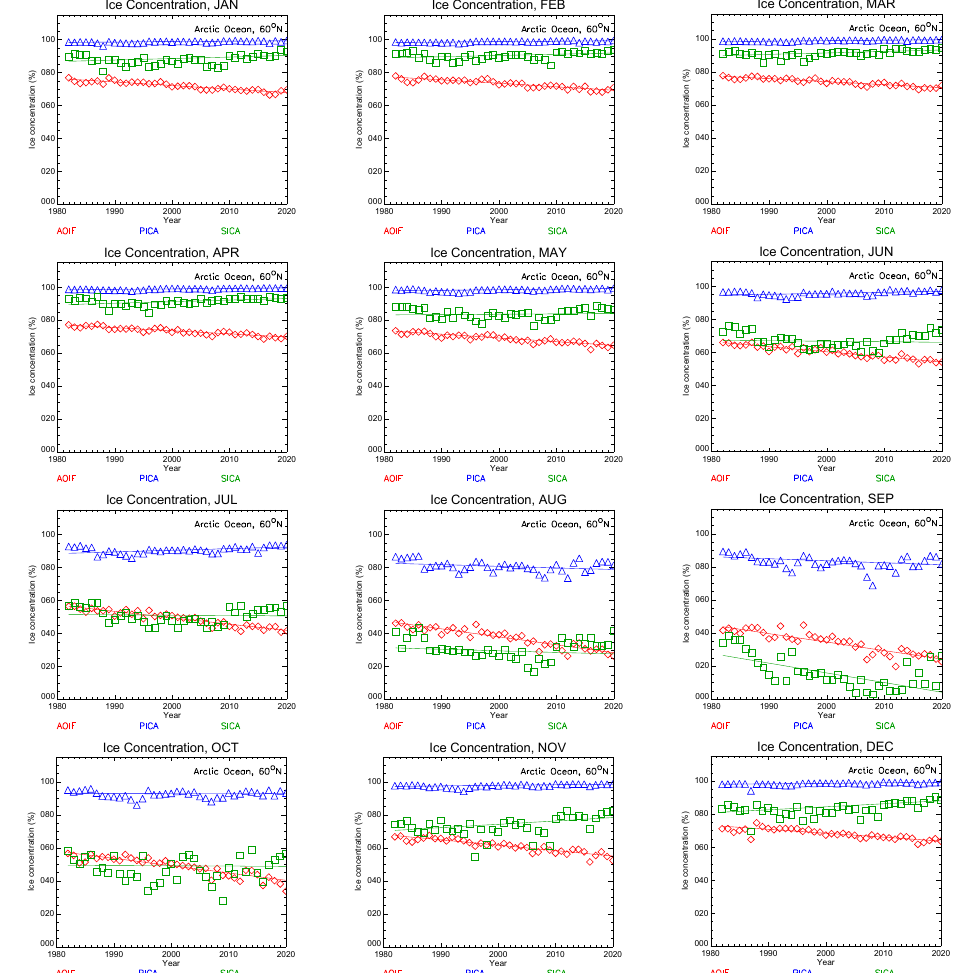
Figure 7. SIC time series for the Arctic area north of 60°N over 1982–2020 for the months of January through December. PICA (blue) stands for perennial ice-covered area, SICA (green) denotes seasonal ice-covered area, and AOIF (red) is the actual fraction of the ice-covered portion over the Arctic area north of 60°N.